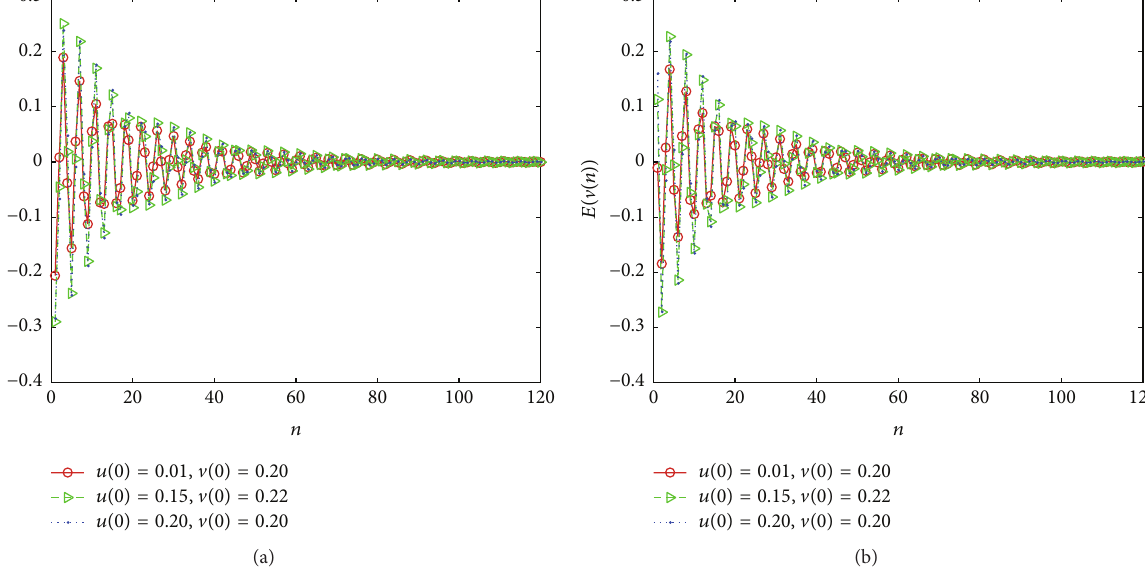
Figure 6: Time history diagrams of the controlled delayed species model (21) for 𝛿 = 0.001 , 𝑘 4 = 0.1 . The initial values 𝑢(0) and V (0) take random values covering [0, 0.5]